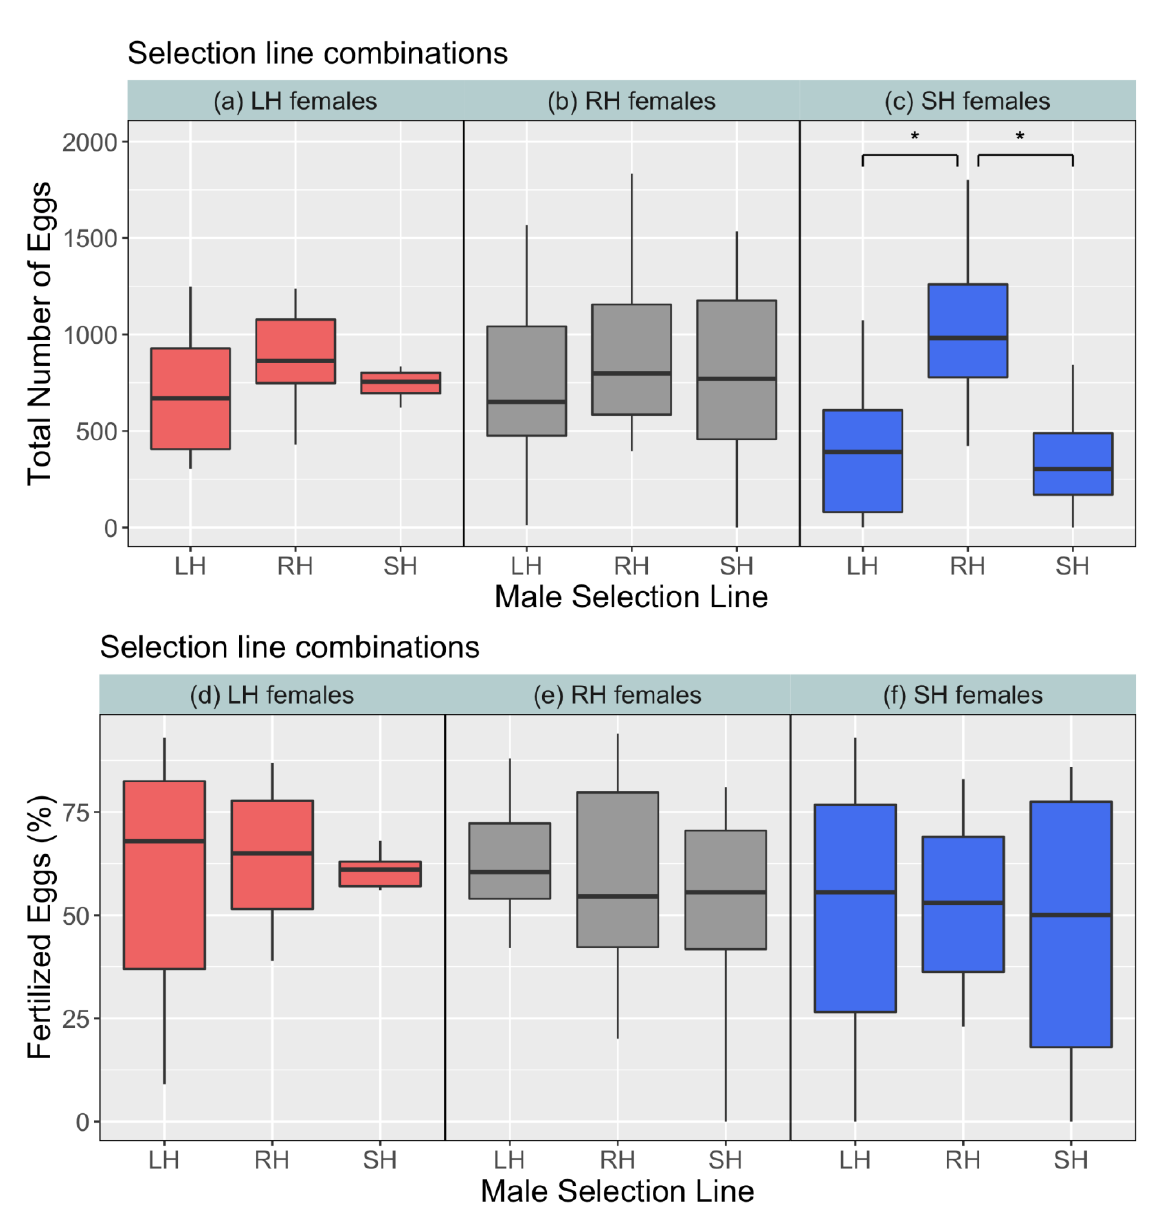
Figure 5. Comparison of total no. of eggs spawned by females ( a – c ) and percentage of eggs fertilised by males ( d – f ) among the selection lines. Significance code: ( p < 0.05) ‘*’